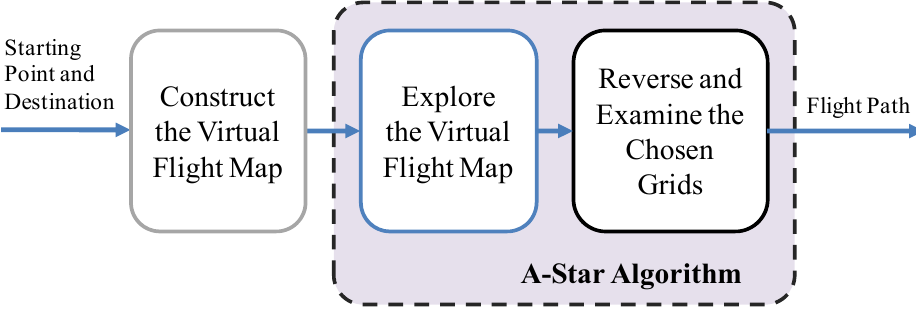
Figure 3. The block diagram of the developed FPPS.